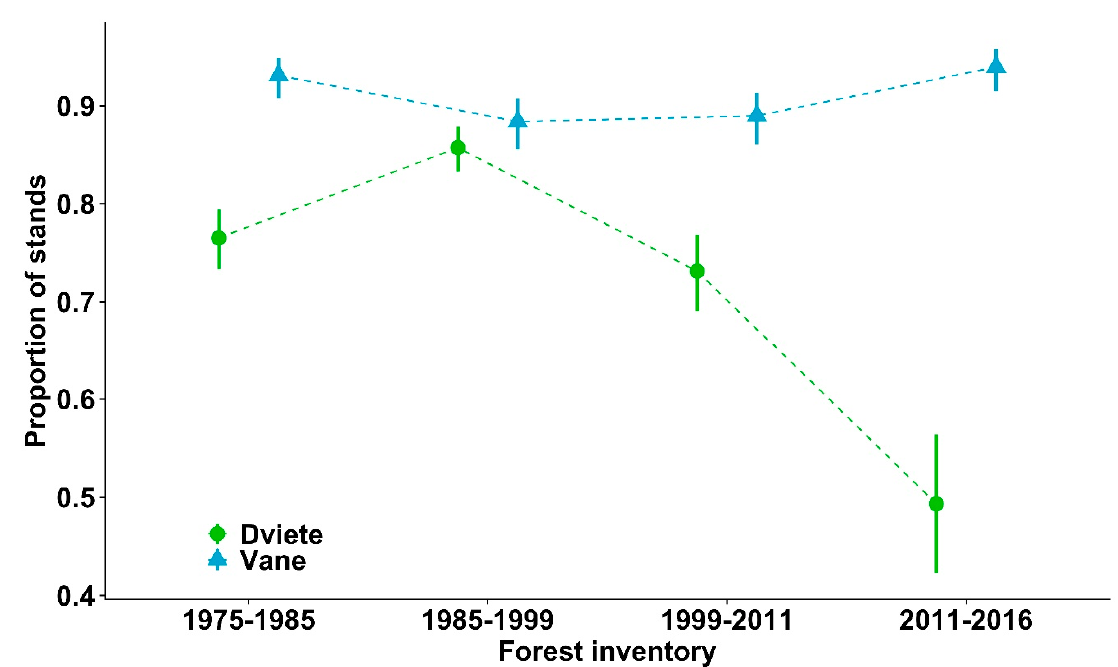
Figure 5. The transition of Norway spruce stands in two landscapes between two consecutive forest inventories ( ± 95% confidence interval).